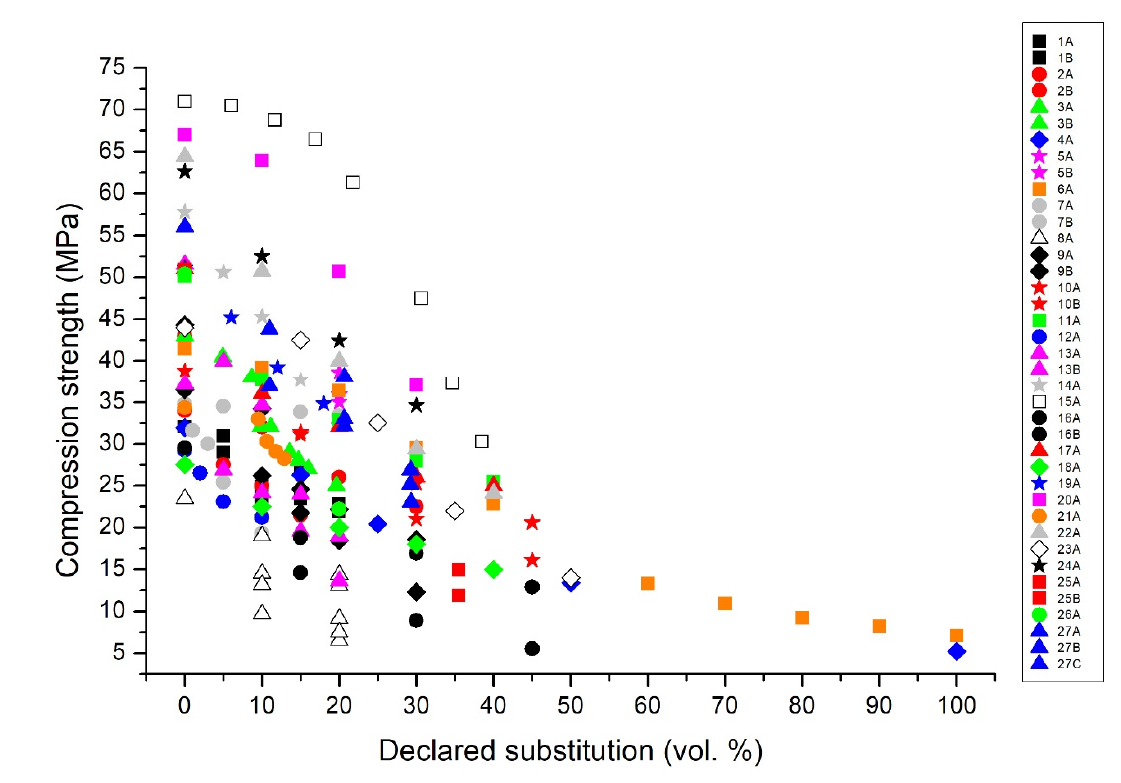
Figure 1. Reference diagram: compression strength (expressed in MPa) vs. the declared volumetric percentage of substitution of the mineral aggregate with rubber (expressed in vol.%).